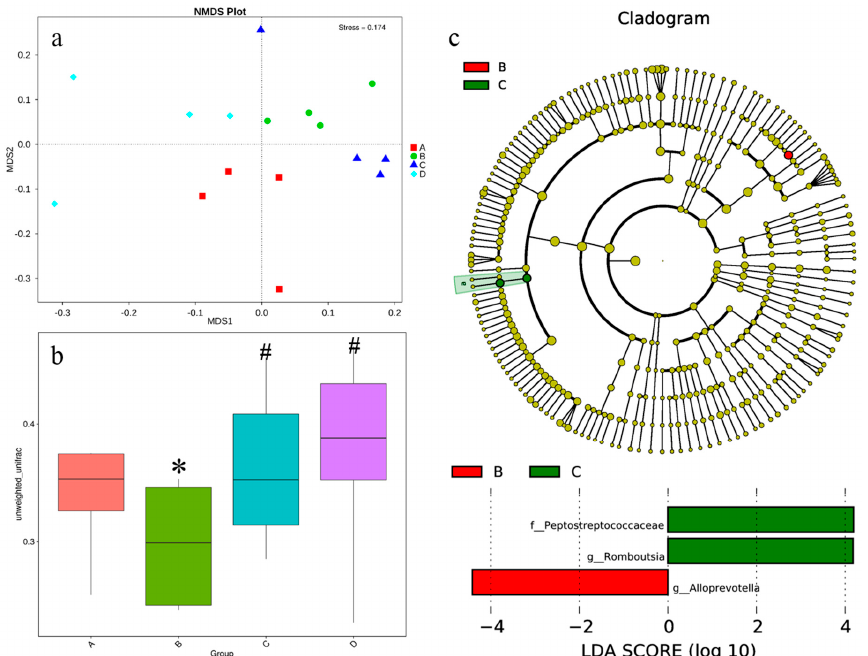
Figure 5. Beta diversity of caecal microbiota between groups ( n = 4 in each group). Note: * shows a statistical significant difference compared with the control group with standard diet ( p < 0.05). # shows a statistical significant difference compared with the high-salt diet group ( p < 0.05). A: control group with standard diet (0.4% NaCl); B: high-salt diet (4.0% NaCl); C: high-salt diet (4.0% NaCl) with 0.5% betaine; D: high-salt diet (4.0% NaCl) with 1.0% betaine; ( a ) nonmetric multidimensional scaling (NMDS) plot; ( b ) unweighted_unifrac; ( c ) linear discriminant analysis effect size (LEfSe) analysis.